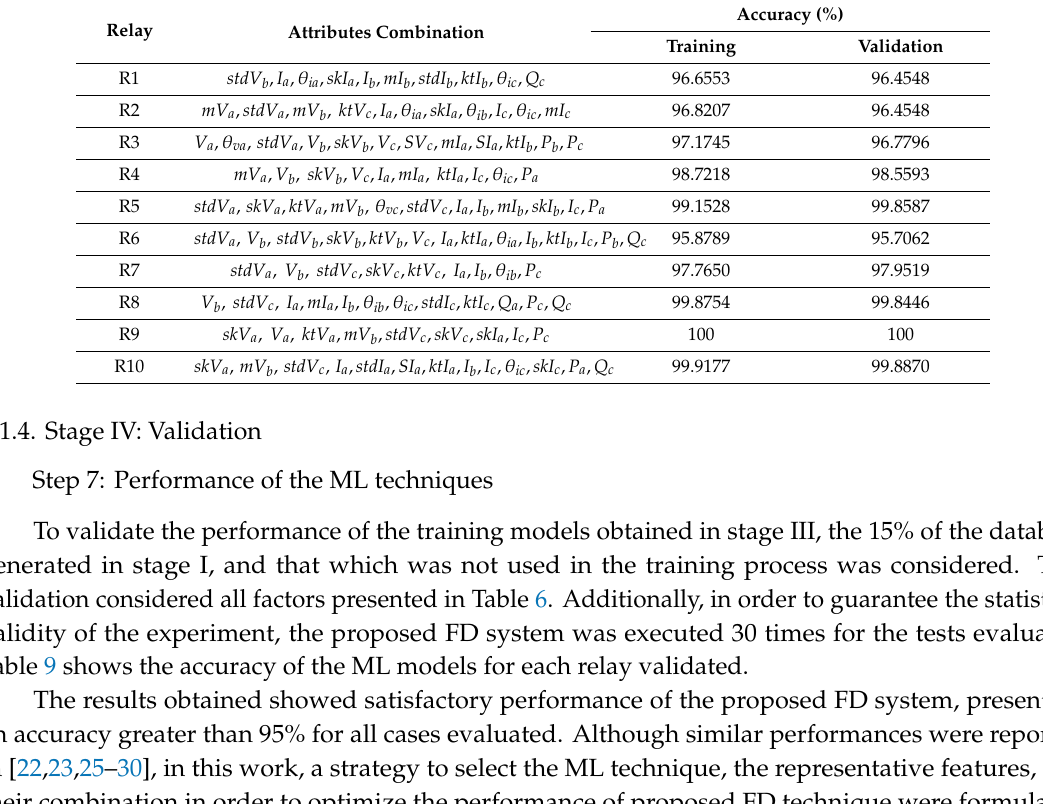
Table 9. Training and validation results.